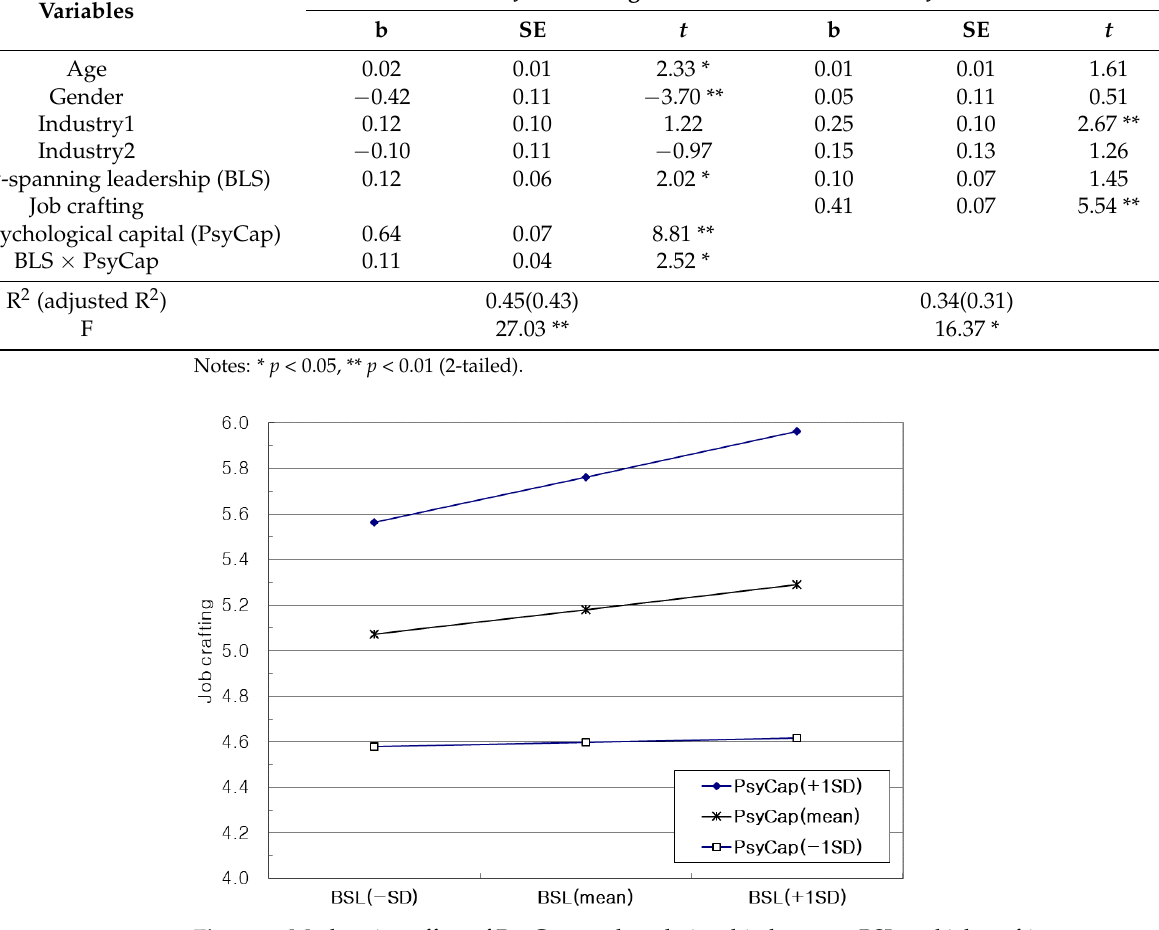
Figure 2. Moderating effect of PsyCap on the relationship between BSL and job crafting.